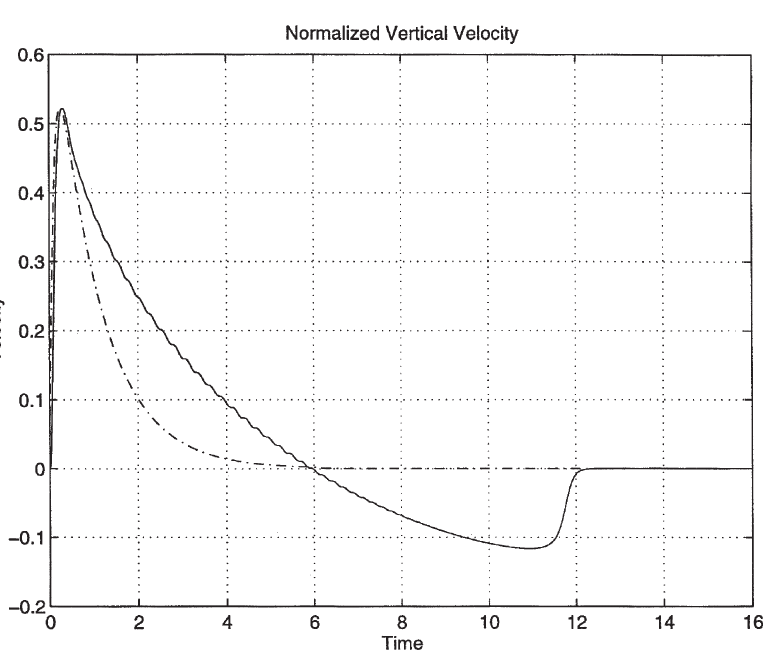
Fig. 5. Normalized vertical velocity for Bleich–Sandler plate (solid Line CFA on; -.-.- CFA off).